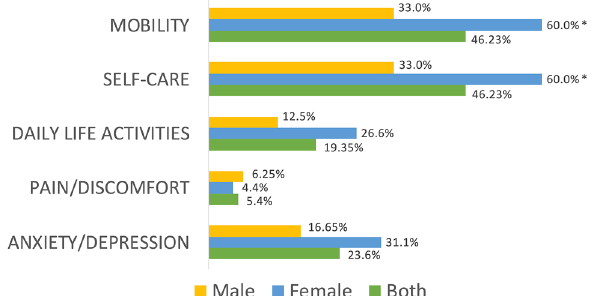
Figure 1. Distribution of the percentage of women and men exhibiting limitations on each domain of the EQ-5D-5L questionnaire. Asterisk: significant differences between men and women (P < 0.01).